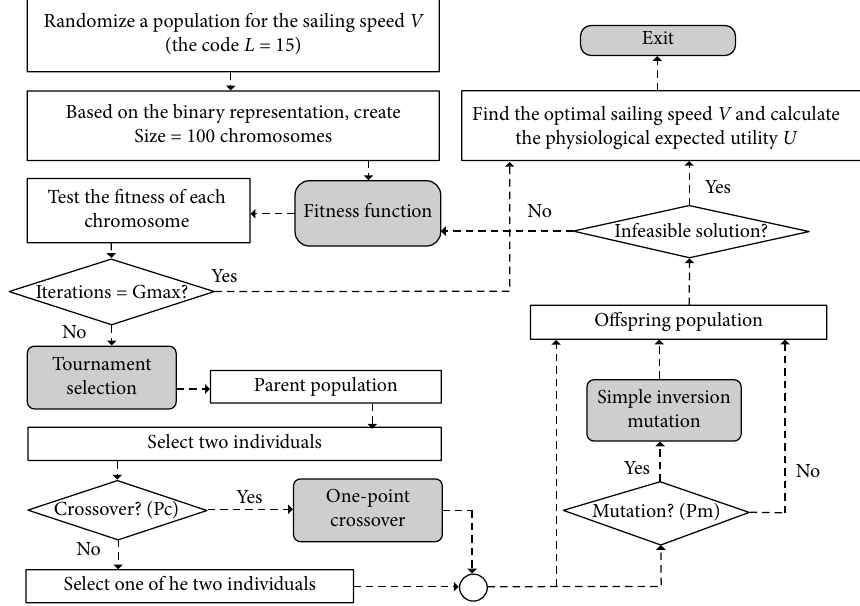
Figure 1: Flowchart of the proposed